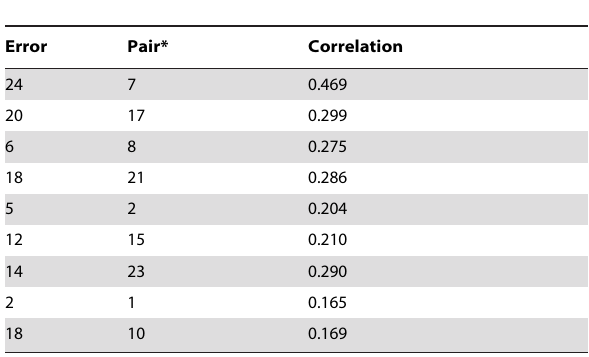
Table 4. Correlation between error